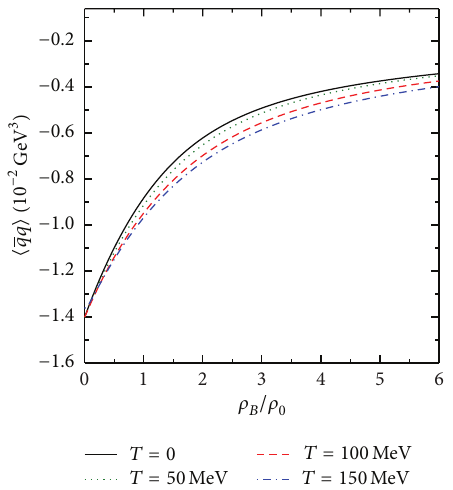
Figure 1: (Color online) The light quark condensate 𝑞𝑞 plotted as a function of density of the nuclear medium, in units of nuclear saturation density, for different values of temperatures ( 𝑇 = 0, 50, 100 , and 150MeV).